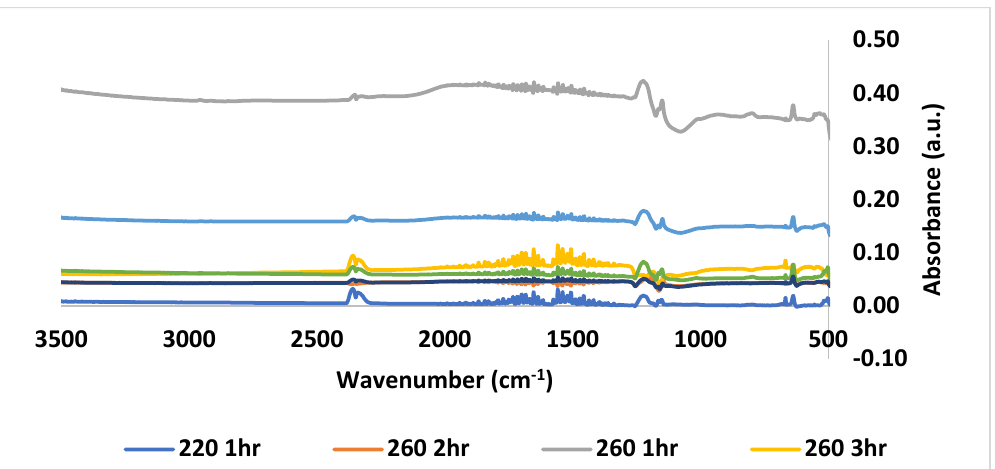
Figure 5. FTIR results for CDs generated at different temperature and residence times in bottom-up synthesis. Samples were freeze-dried, dispersed in toluene, then tested as liquids.